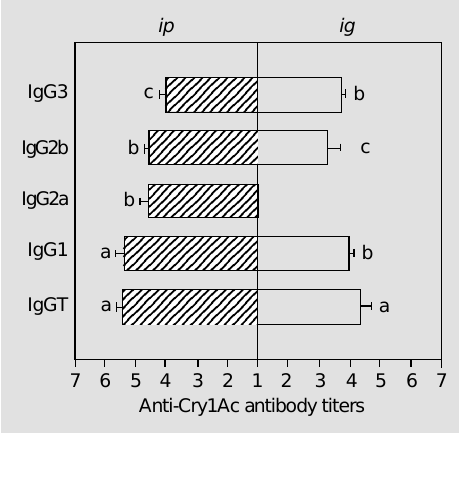
Figure 3 - Subclasses of anti- pCry1Ac IgG coproantibodies in the large intestine fluids after ip or ig immunization with 100 µg of pCry1Ac. The mean A 492 val- ues of nonimmunized mice were 0.091 ± 0.012. Bars represent the level of antibodies reported as arbitrary units of A 492 ± SD for each experimental group (N = 5). The letters on top of the bars represent the differences observed by the Newman-Keuls test (P<0.01).